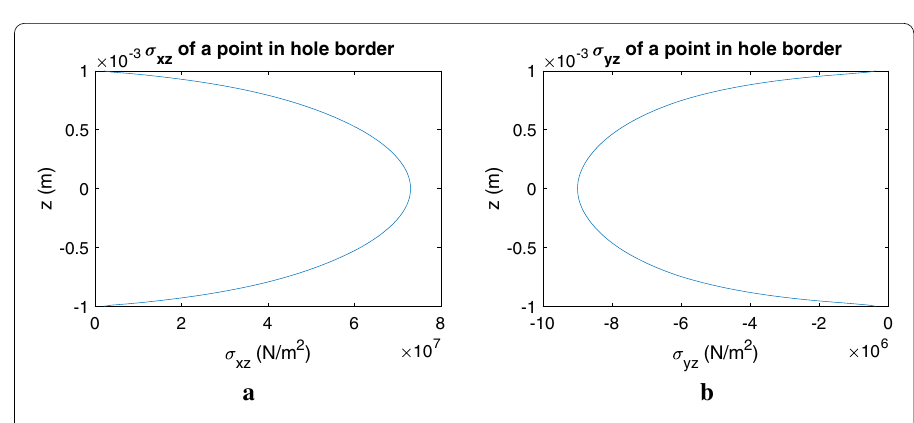
Fig. 11 Out-of-plane components of the stress tensor through the domain thickness in the hole neighborhood